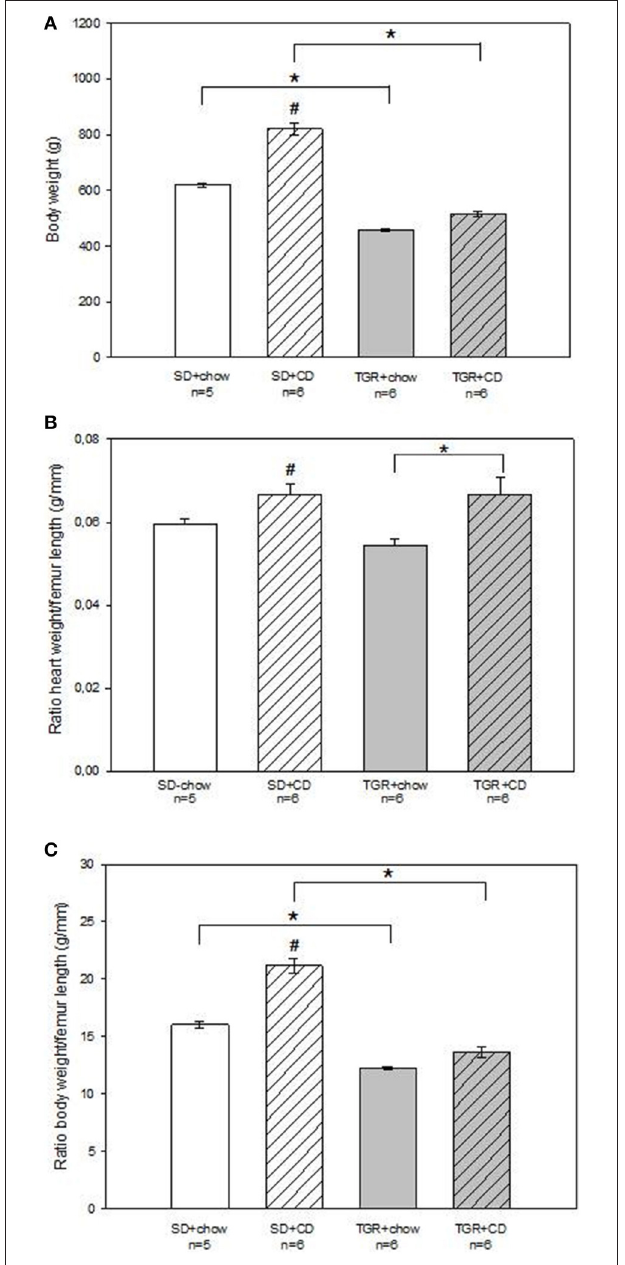
FIGURE 1 | Body parameters of male wild type Sprague Dawley rats (SD) and transgenic rats (TGR), overexpressing Ang(1-7) after a 5 month feeding period with either standard chow alone or simultaneously chow and cafeteria diet (CD). CD increased body weight (A) , altered heart weight to femur length ratio (B) and elevated body weight to femur length ratio (C) in wild type SD rats. In transgenic rats an overexpression of Ang(1-7) prevented the CD-induced effects on body parameters. Data expressed as means ± SEM of n experiments. Significant changes vs. chow rats are indicated by a hash key ( p < 0.05 ), significant changes between groups are indicated by an asterisk ( p < 0.05 ). Body weight was analyzed by Kruskal-Wallis followed by pairwise comparison using the Dwass-Steele-Chritchlow-Fligner. Heart weight to femur length ratio and body weight to femur length ratio were analyzed by ANOVA followed by pairwise comparison using Tukey